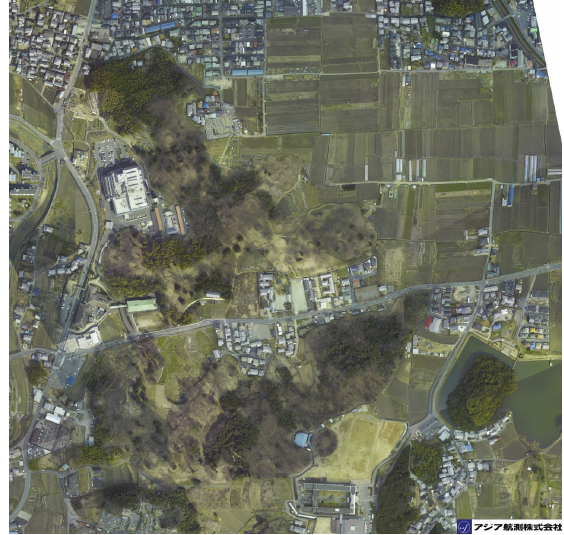
Fig10. Nizawa-senduka (Ortho Photo